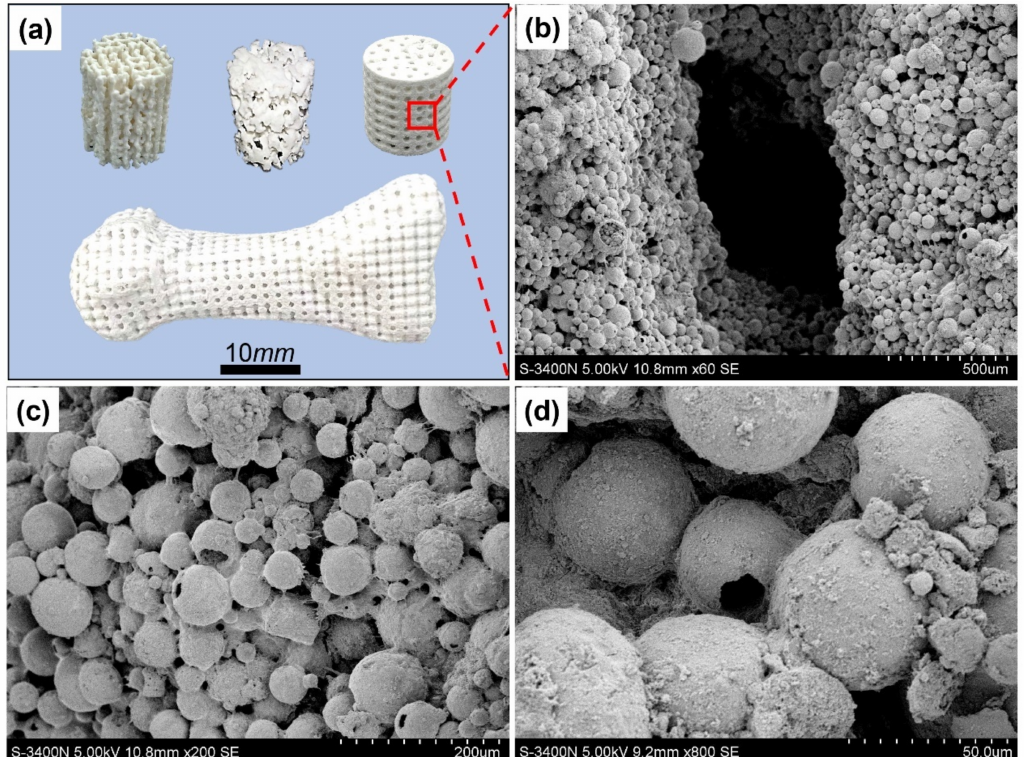
Figure 1. 3D printed HA bone scaffolds ( a ) and the SEM microstructure images of scaffolds at different magnifications ( b – d ). The 3D printed bone scaffolds are the accumulation of bioceramic powder particles. The powder-droplet interaction plays a key role in quality of 3D printed bone